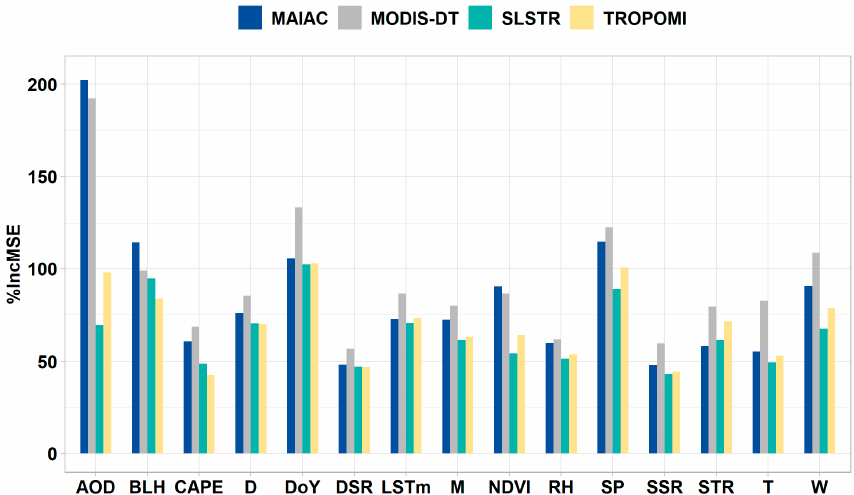
Figure 3. Feature importance rankings for the di ff erent datasets, showing the increase in prediction error when permuting the respective variables in the random